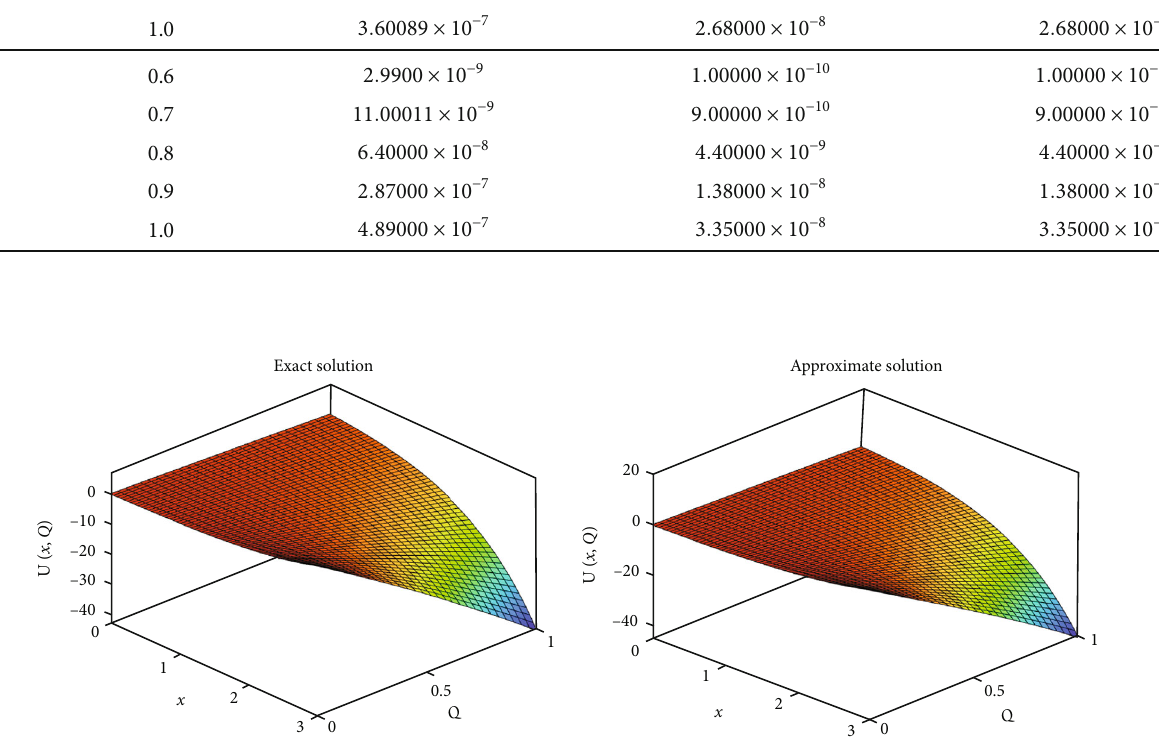
Table 4: For estimated outcomes of U ð y Example